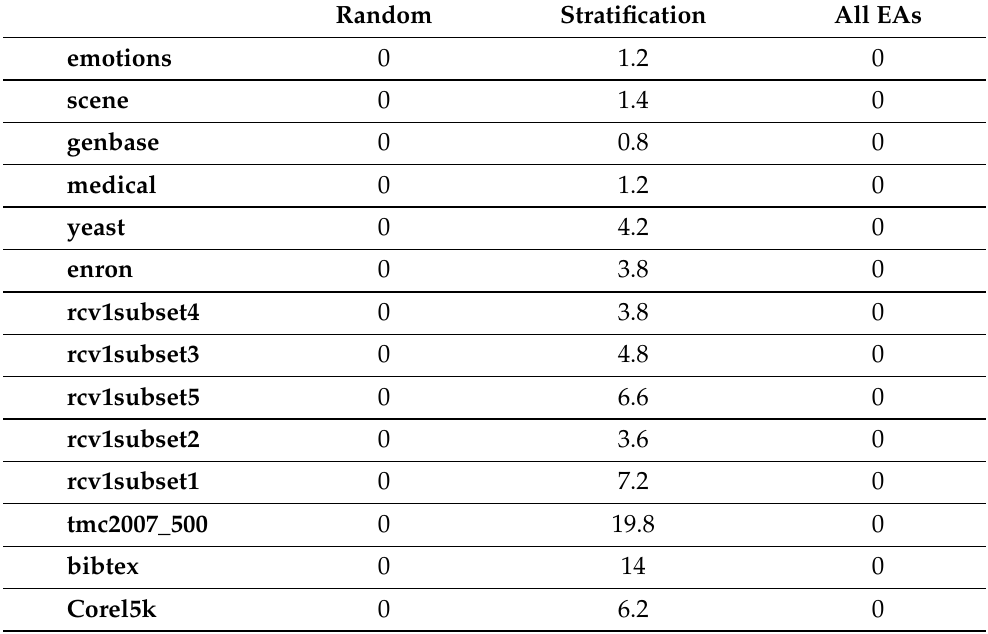
Table 5. Examples Distribution of different splitting algorithms. Only the stratification method deviates from zero.